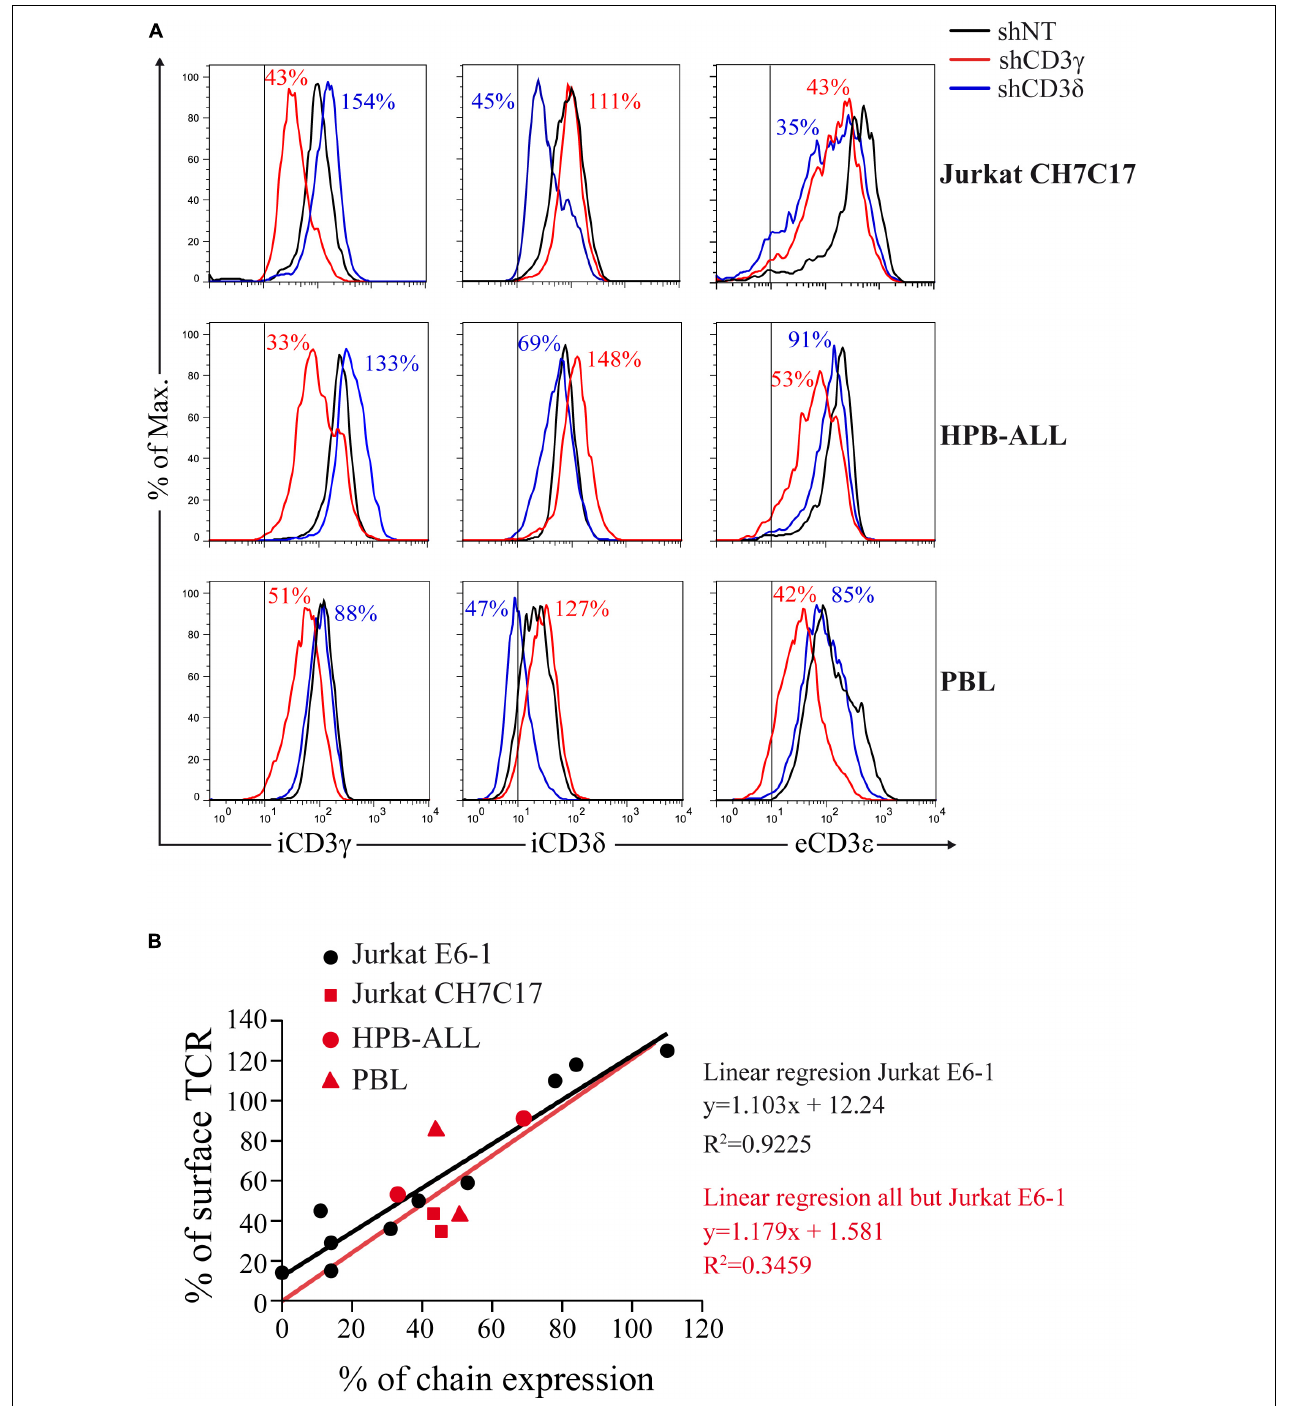
FIGURE 7 | CD3 KD and surface TCR expression correlate in T cells other than Jurkat E6-1. (A) Comparative intracellular (i) CD3 γ or CD3 δ expression and extracellular (e) CD3 ε expression in the indicated T cells transduced with shCD3 γ , shCD3 δ , or shNT. Vertical lines indicate the upper limit staining of the isotype control. Numbers indicate % expression vs. control (shNT). (B) Correlation between CD3 γ or CD3 δ chain expression and surface TCR, expressed as % of expression vs. shNT. Data in (A) (red symbols) in comparison with Jurkat E6-1 data (black dots) and comparative linear regression. The slopes are not significantly different ( P =